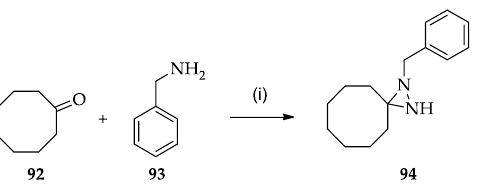
Figure 13. Solvent dependency of N -monosubstituted diaziridine 94 . Conditions: (i) HOSA, rt, 3 h, solvent (pentane, hexane, dichloromethane, cyclohexane, toluene, acetonitrile, diethyl ether, tetrahydrofuran, methyl tert- butyl ether, ethyl acetate, methanol, ethanol, isopropyl alcohol, 1-butanol, 1,4-butanediol).